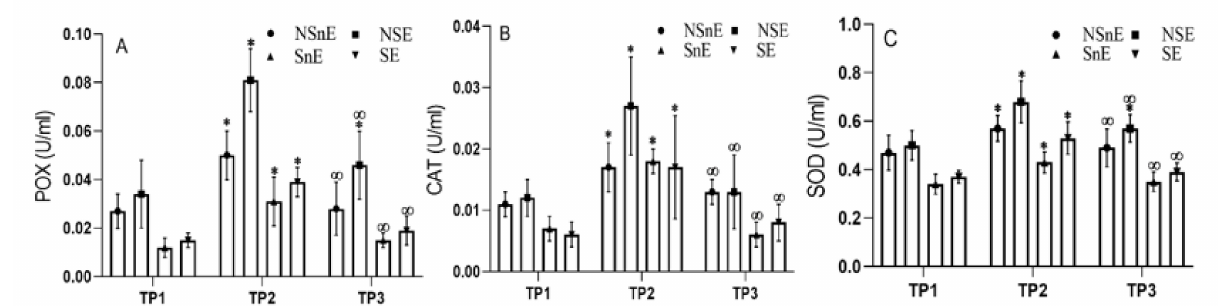
Figure 4. Change in ( A ) POX = peroxidase, ( B ) CAT = catalase, and ( C ) SOD = superoxide dismutase for each time point. * Represents a statistically significant difference compared to TP1 ( p < 0.05); ∞ Represents a statistically significant difference compared to TP2 ( p < 0.05); TP1 = time point from Pre-test, TP2 = time point immediately after the test, TP3 = time point one hour after the test; NSnE = non-smokers that did not exercise; NSE = non-smokers that did exercise; SnE = smokers that did not exercise; SE = smokers that did exercise.